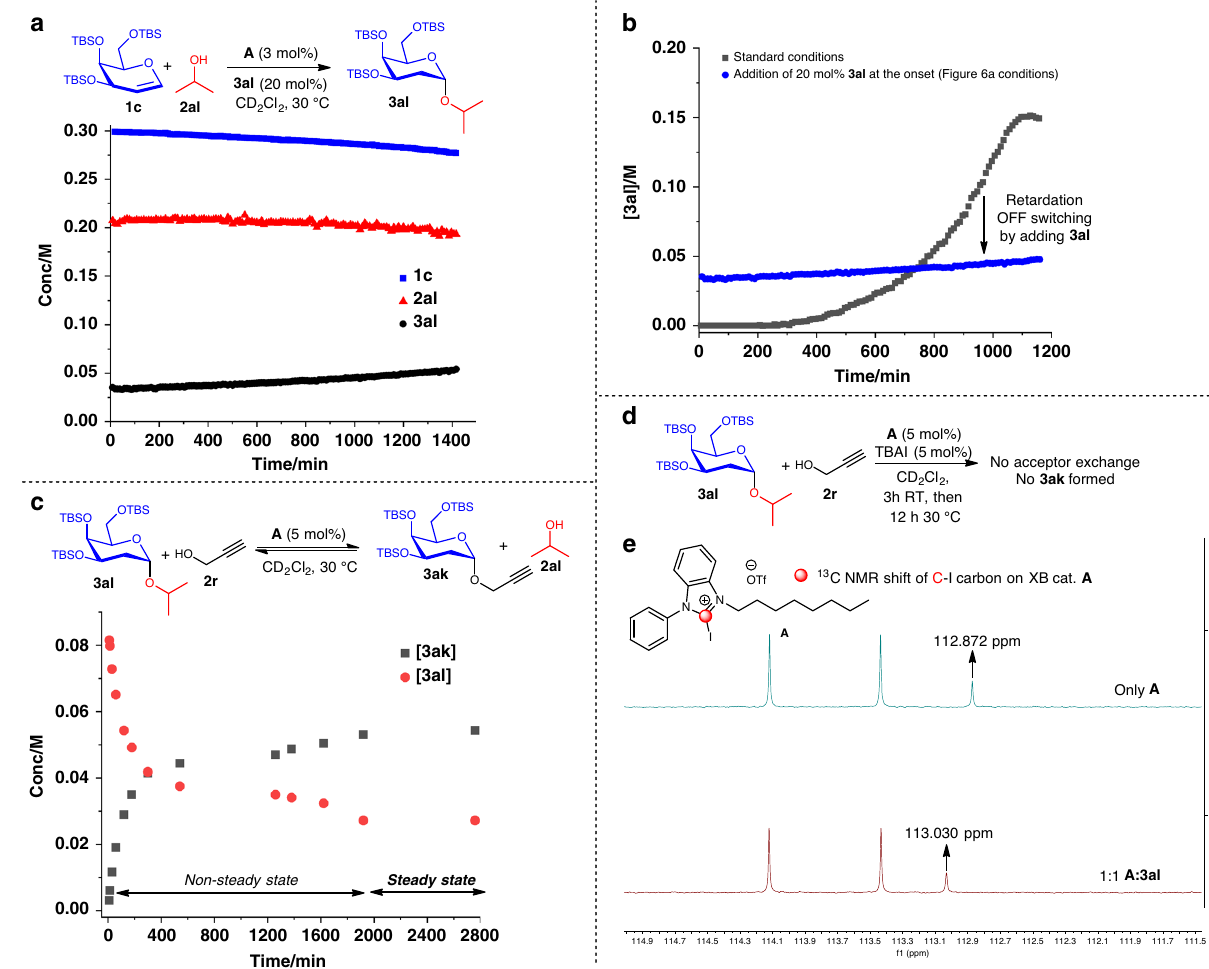
Fig. 8 Dynamic acceptor exchange. a Addition of 20 mol% product at the onset retarded XB catalysis. b Comparison of 3al formation kinetics of standard vs conditions in a . c Acceptor exchange experiment to ascertain dynamic acceptor exchange. d Competition experiment with TBAI showed XB catalyst poisoning halted the dynamic acceptor exchange. e 1:1 adduct of catalyst A to 3al revealed a down fi eld 13 C NMR